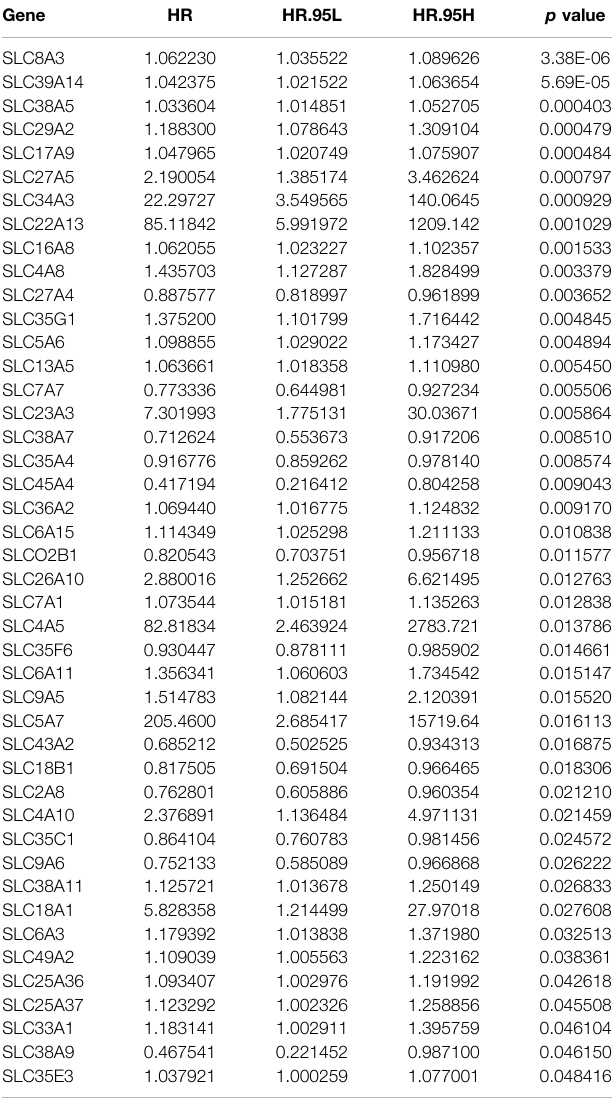
TABLE 1 | The detailed information of prognosis-related SLC genes in the univariate Cox regression analysis. Gene HR HR.95L HR.95H p